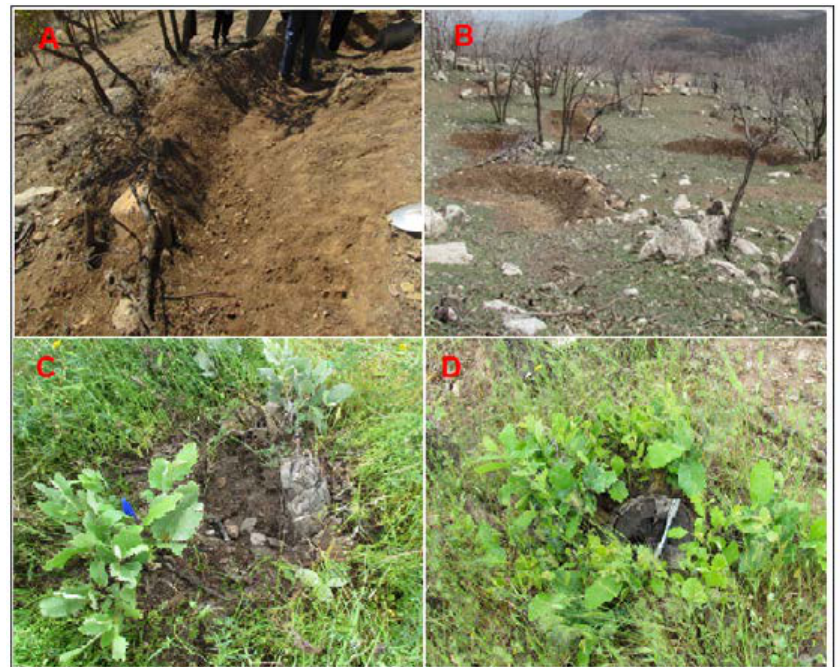
Fig. 4: Semi-circular bunds (A and B) and their effect on re-vegetation of oak (C and D) after three years